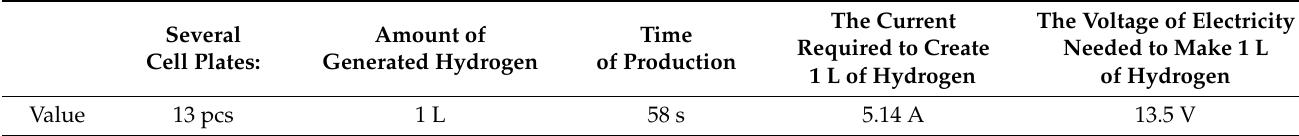
Table 3. Results achieved during the production of